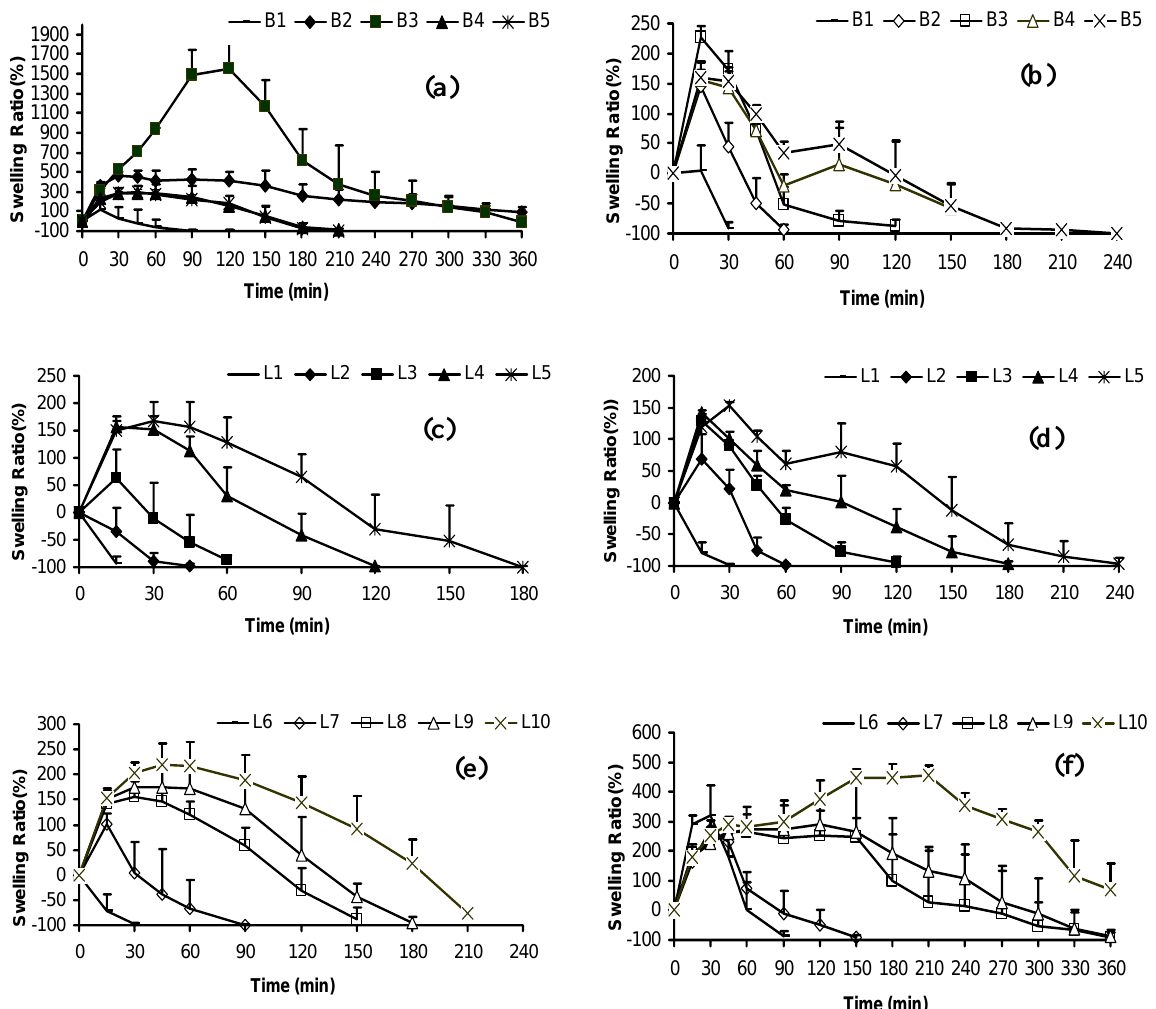
Figure 3. Swelling Ratio of chitosan and freeze-dried systems in demineralized water (a, c and e) and in progressive pH medium (1.5 → 4 → 6.8) (b, d and